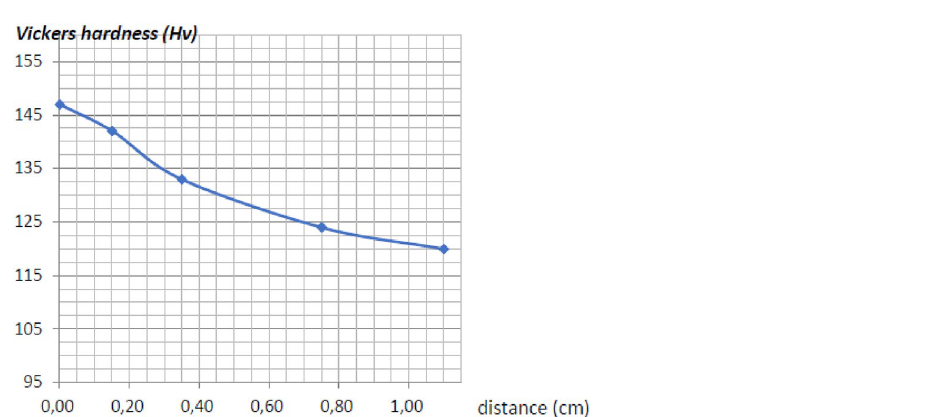
Figure 5. Vickers hardness values in terms of the distance on the welded sectional plan XY (from MZ to